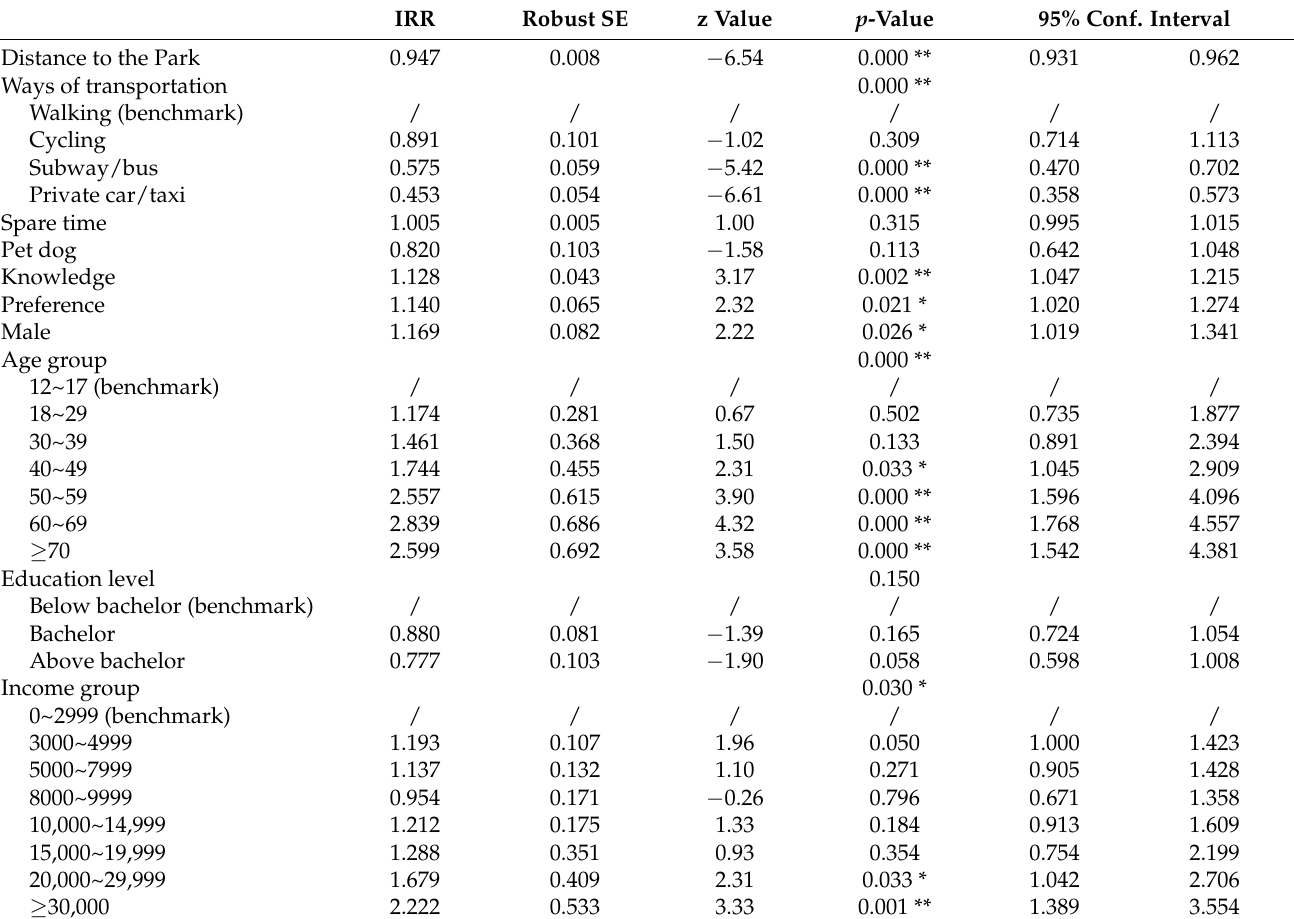
Table 6. Results from zero-truncated Poisson regression on the Park-visiting